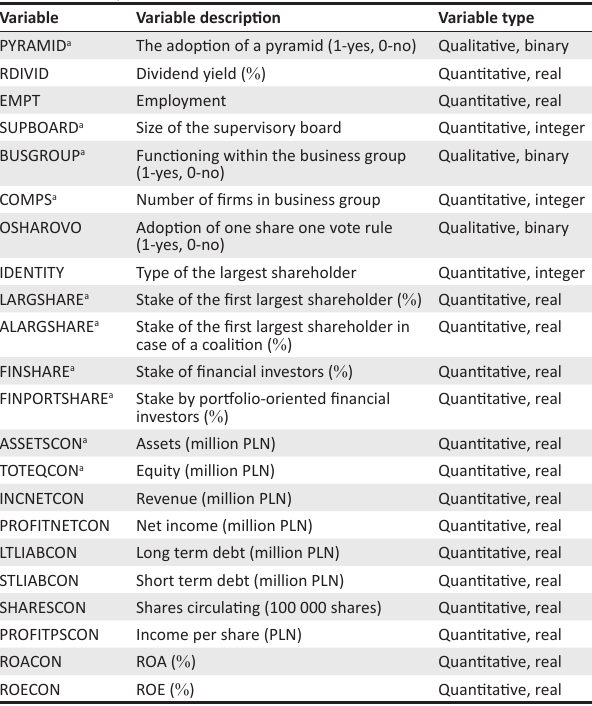
TABLE 1: Description of variables used.